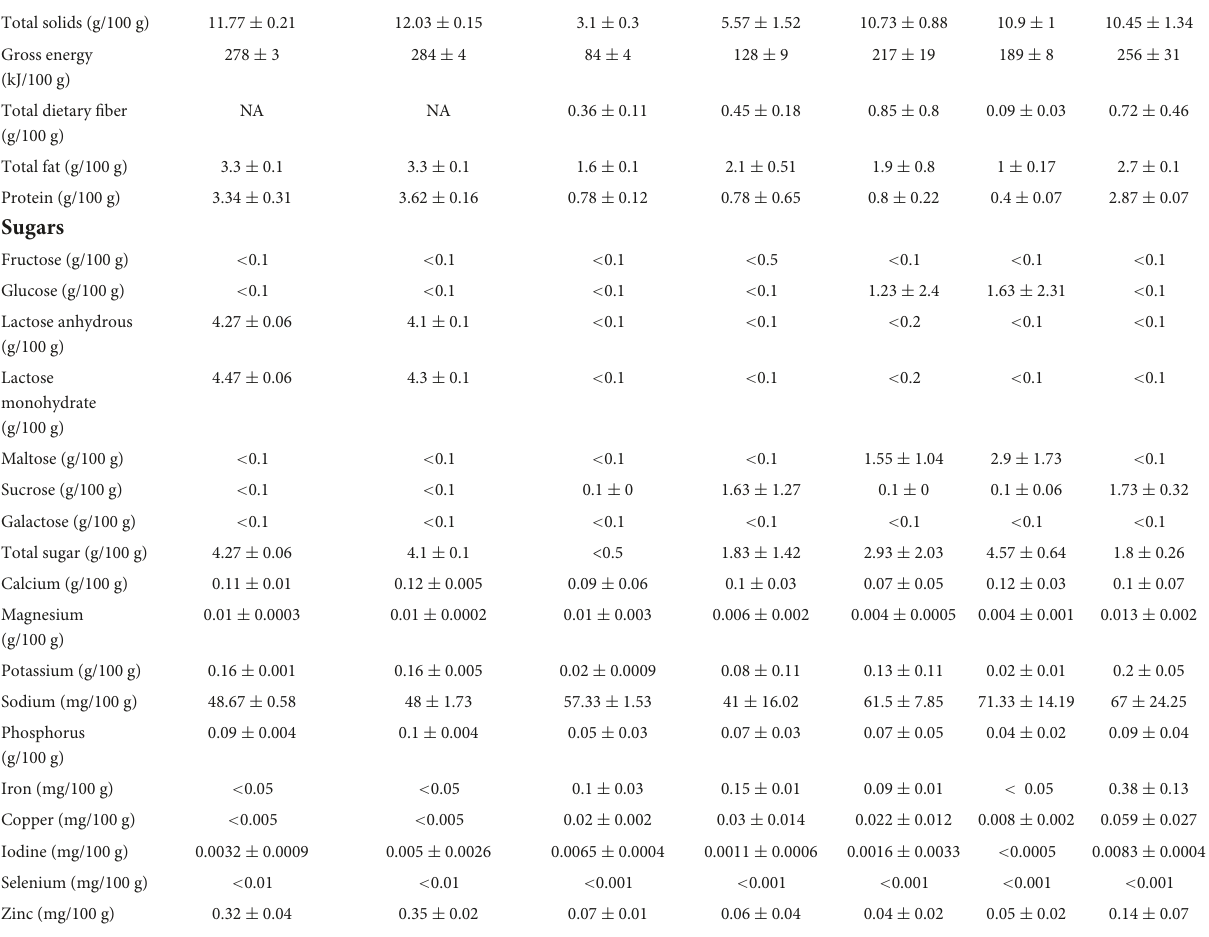
TABLE 2 Analyzed contents of selected samples for each product